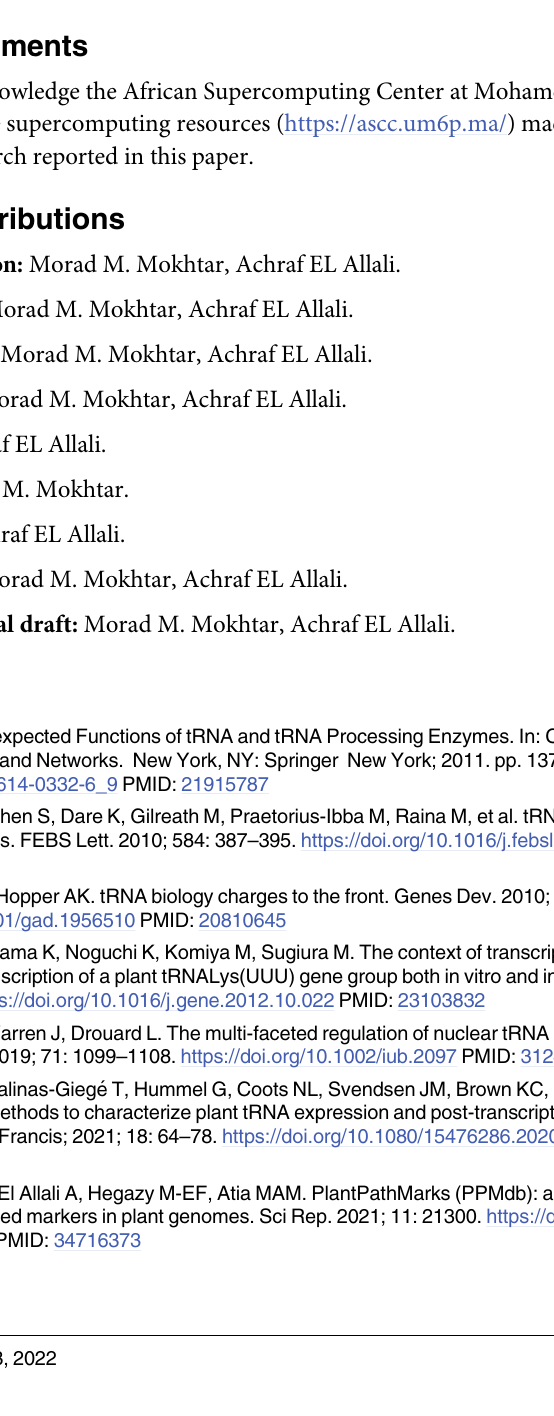
S3 Table. Comparison between tRNAs in PltRNAdb and tRNAs provided by NCBI for Arabidopsis thaliana . S1 Fig. An example of the bulk download page. The first subsection is used to select the plant species, and the second subsection is used to select the type of data to download. (PNG) S2 Fig. An example of the tRNA BLAST webservice. A) The BLAST interface webpage, B) The results